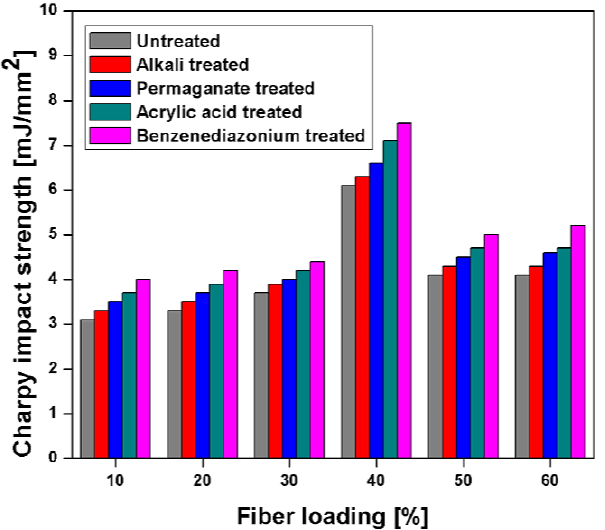
Figure 14. Influence of chemical treatment on impact strengths at different fiber loading (10–60 wt.%) of abaca-reinforced epoxy composite.